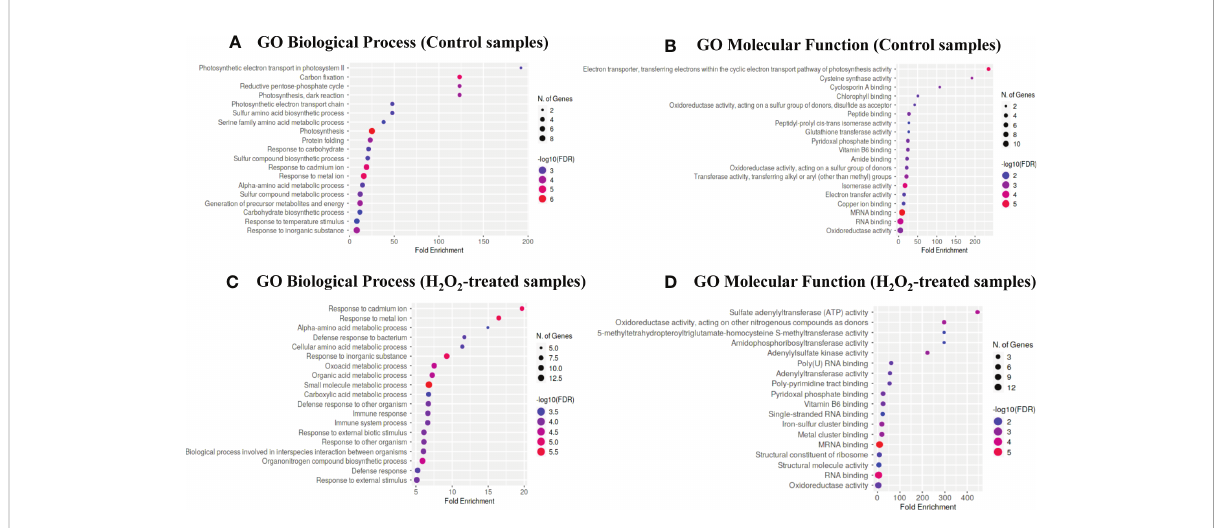
FIGURE 3 Gene ontology enrichment analysis. The bubble chart of the top 20 Gene Ontology (GO)-terms represented by the carbonylated proteins in the control plant samples (T0) and H 2 O 2 -treated plant samples (T20) were generated using the ShinyGO v0.76 web-based bioinformatics resource. (A – C) biological processes. (B – D) molecular function. The x-axis indicates fold enrichment. The y-axis indicates GO